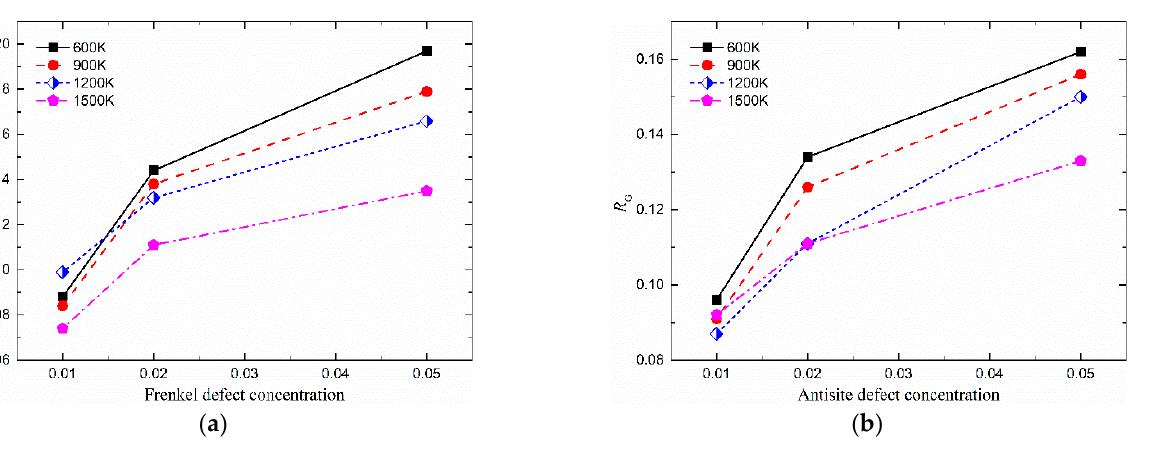
Figure 9. R G as a function of the concentration of Frenkel defects ( a ) and antisites ( b ) at different temperatures.